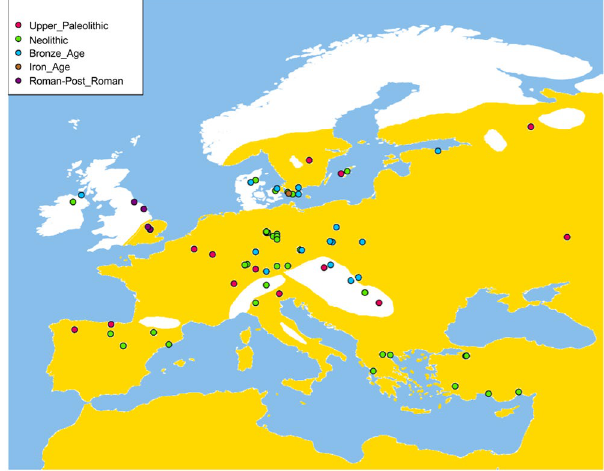
Figure 1. Geographical distribution of ancient European samples included in the analysis of the malaria- resistant mutations. The map depicts the malaria-endemic zone 57 . The map was made using Worldmap package 1.3.1 of R software 3.2.2 (http://cran.r-project.org), and modified with Gimp 2.6 (https://www.gimp.org) and Pinta 1.6